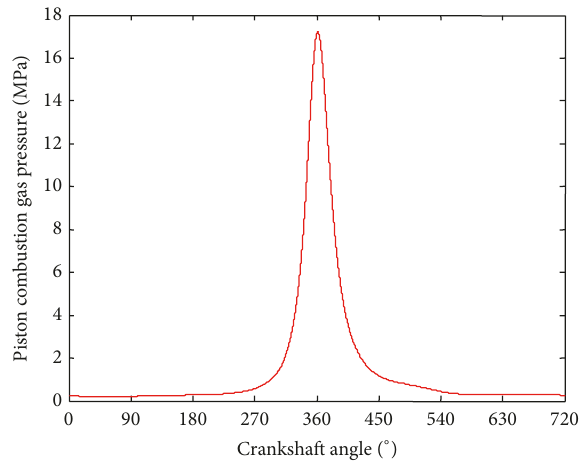
Figure 7: Gas pressure inside of